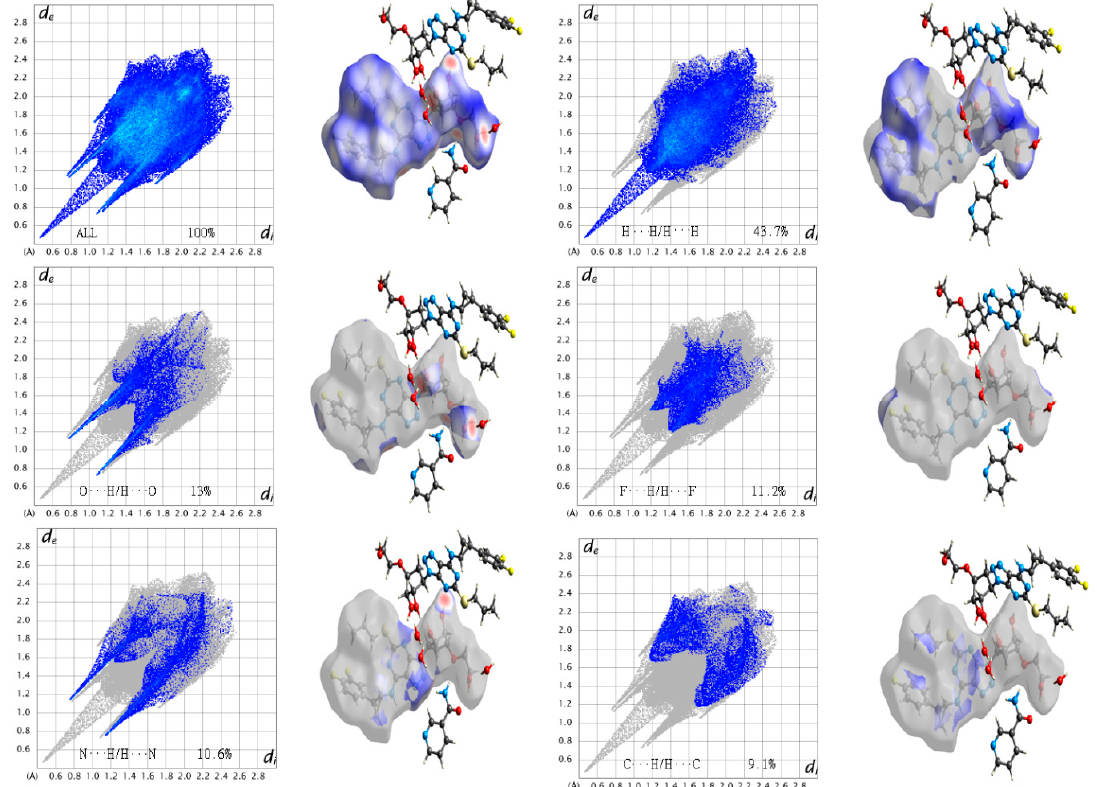
Figure 6. Fingerprint plot of TICA-NCA hydrate full and resolved into H–H/H–H, O–H/H–O,